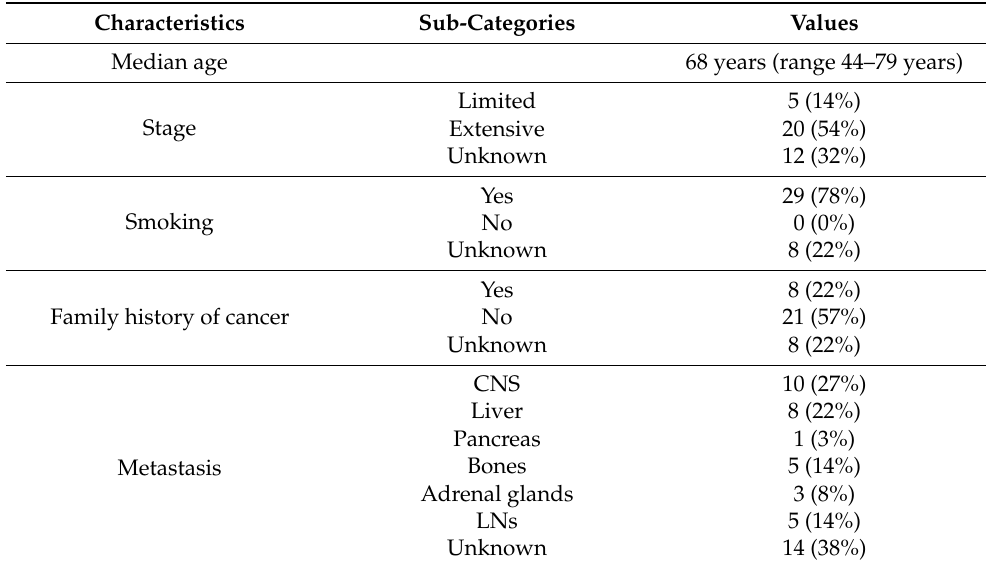
Table 2. SCLC patients’ clinical